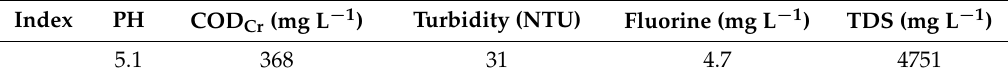
Figure 7. Degradation of curves under different conditions. Table 4. Water quality after coagulation-flocculation.